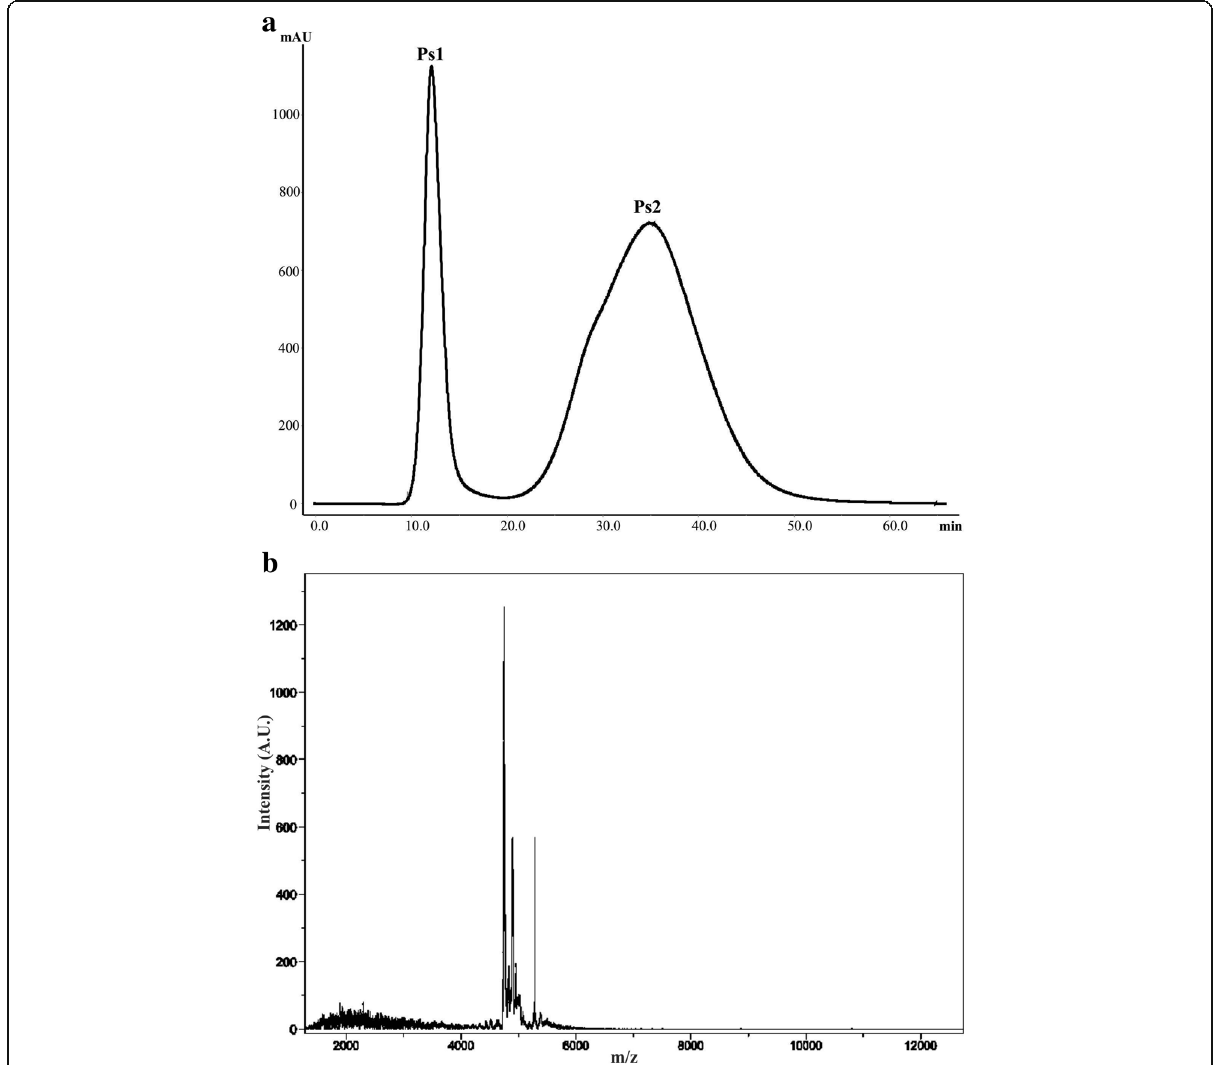
Fig. 6 a P. strigosa extract elution profile obtained by FPLC on a Sephadex G-50 column at 280 nm. The column was equilibrated and eluted with 1.6 mM acetic acid at 1 mL/min. b MALDI-TOF of the second fraction (Ps2) after filtration with ultra-centrifugation filters with 10 K